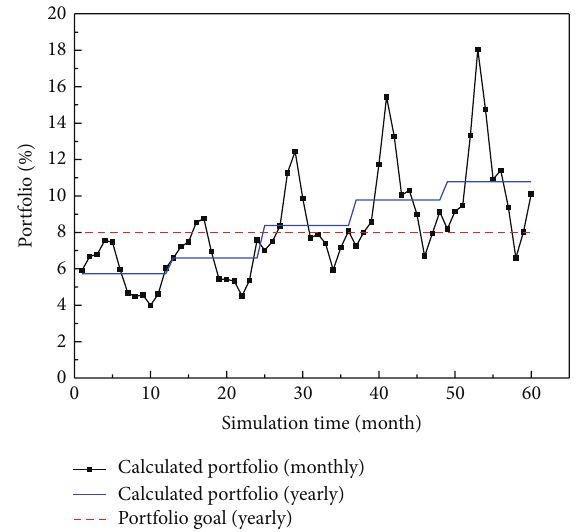
Figure 7: The relationship between calculated portfolio and portfo- lio